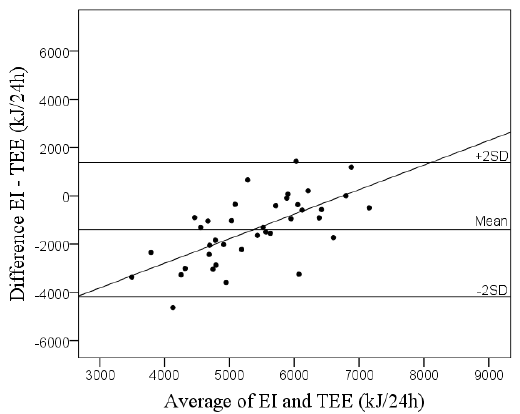
Figure 1. Bland and Altman Plot comparing energy intake using KidMeal ‐ Q and total energy expenditure calculated using doubly labelled water in 38 children aged 5.5 years. The mean difference between methods was − 1400 kJ/24 h with limits of agreement (2SD) of 2775 kJ/24 h. Table 2. Mean intakes and correlations for the selected foods and beverages estimated by KidMeal ‐ Q and 24 h dietary recalls ( n = 38). KidMeal ‐ Q (g/Day) 24 h Dietary Recall (g/Day) 1 p ‐ Value 2 Rho 3 p ‐ Value 4